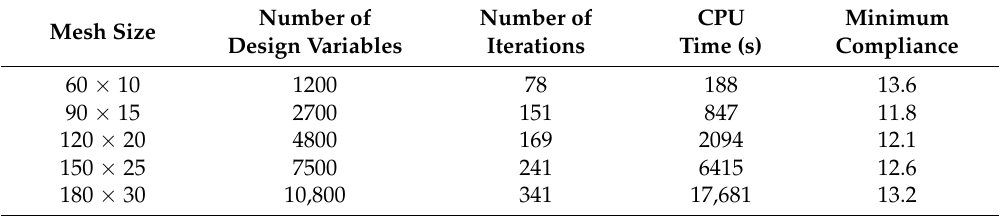
Continuous fiber angle optimization (CFAO) Messerschimitt–Bölkow–Blohm (MBB) optimization results for various mesh sizes. CPU—central processing